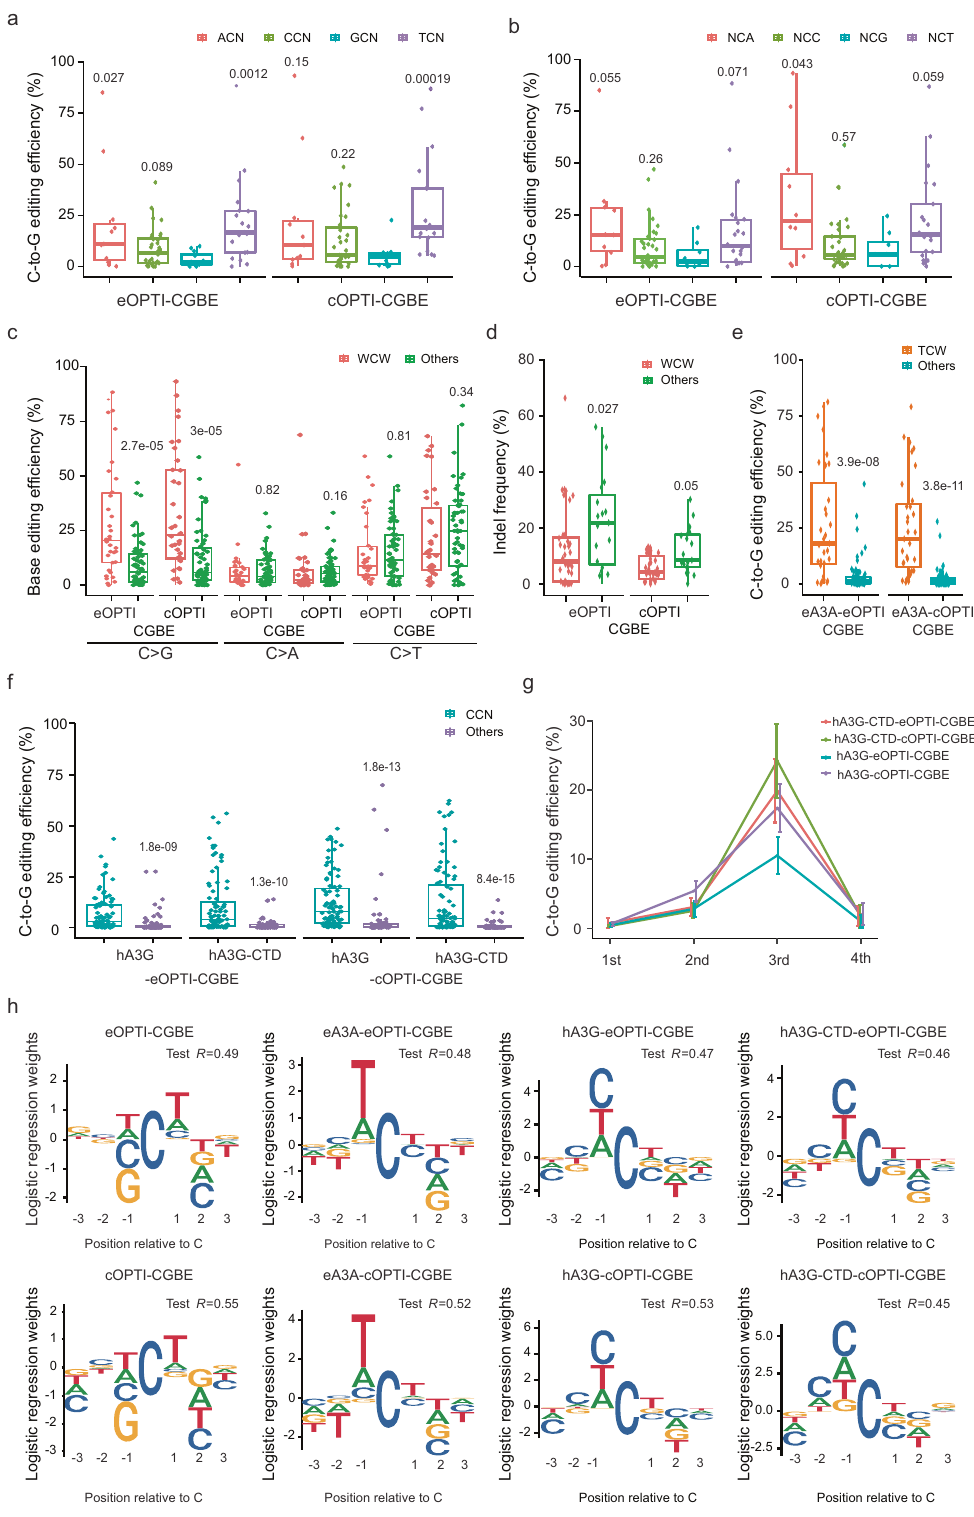
the target sequences in the test dataset ( R = 0.20 – 0.60 for CGBE- SMART_Ef fi ciency; R = 0.37 – 0.60 for CGBE-SMART_Propor- tion; Fig. 3b and Supplementary Fig. 9b, c). Among the eight OPTI-CGBEs, cOPTI-CGBE showed the best performance between predicted editing ef fi ciencies and observed ones in CGBE-SMART_Ef fi ciency model (Fig. 3b). Simultaneously, eA3A-cOPTI-CGBE achieved a correlation coef fi cient of 0.6